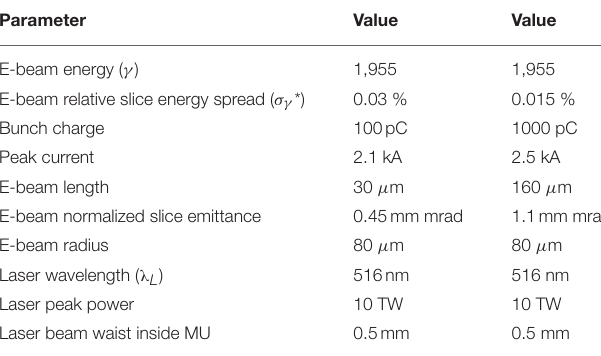
TABLE 1 | Parameters used in the simulations with 100pC and 1000pC bunch